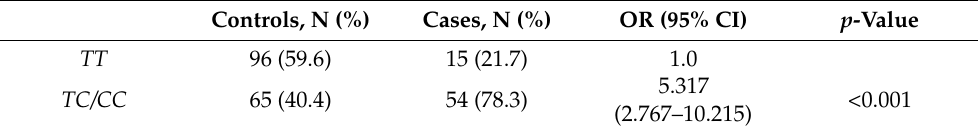
Table 5. Distribution of CYP19A1 codon 39 polymorphisms in women with PCOS and controls (fertile